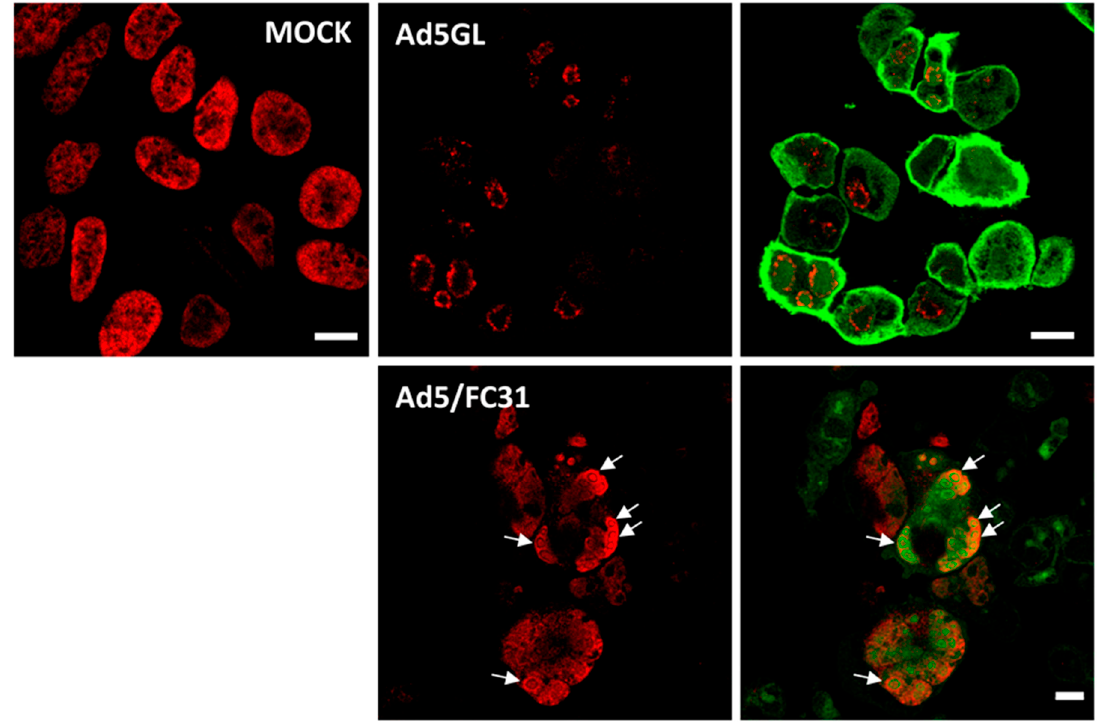
Figure 4. Labeling with two doses of BrdU. Confocal planes showing HEK293 cells uninfected (MOCK) or infected with Ad5GL or Ad5/FC31 at MOI = 50, as indicated. BrdU (25 µg/mL) was added first at 18 and then at 25 hpi. The cells were observed at 36 hpi. Red: BrdU, green: GFP labeled with anti-GFP antibodies in Ad5GL, GFP expressed by the virus in Ad5/FC31. See Section 3.5 for details about GFP labeling. White arrows point to concentric rings. Scale bar 10 µm.